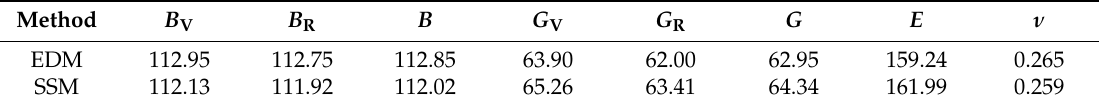
Table 4. The Voigt, Reuss, and Hill bulk ( B V , B R , B in GPa) and shear ( G V , G R , G in GPa) moduli, Young’s modulus ( E in GPa) and Poisson ratio ( ν ) of polycrystalline B19 TiAl. Method B